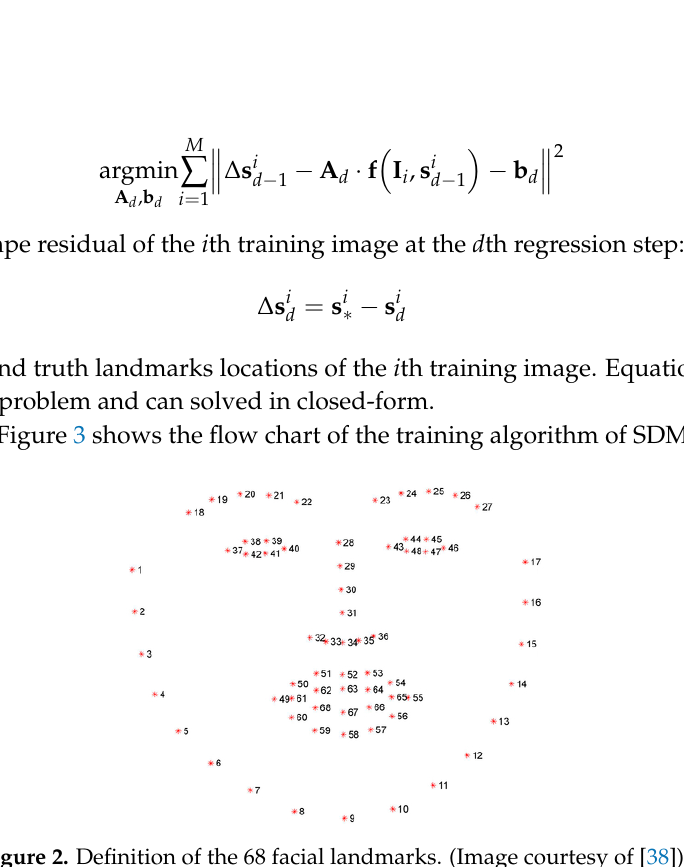
Figure 3. The flow chart of the training algorithm of SDM.